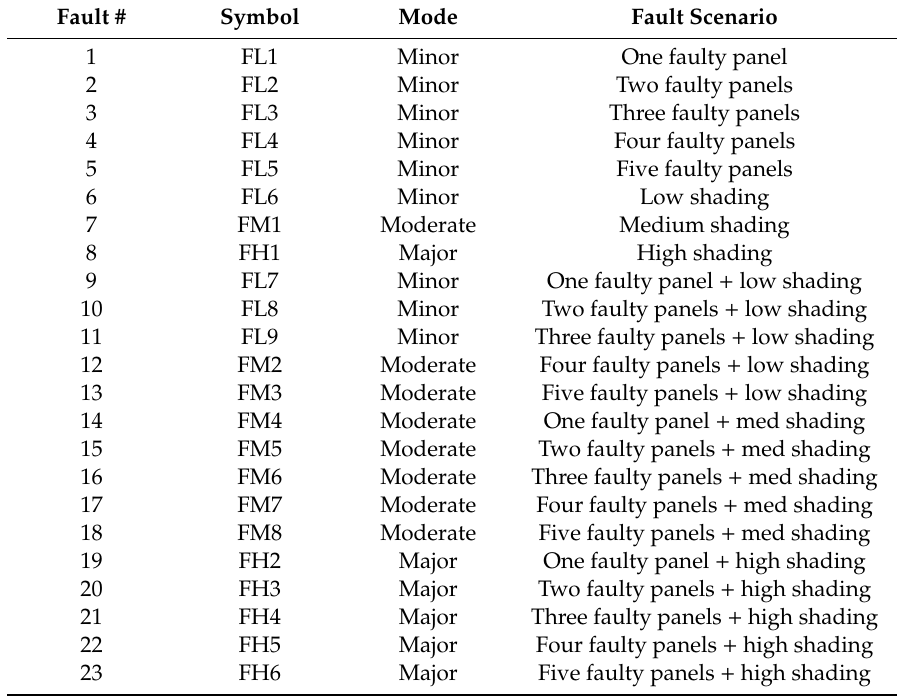
Table 2. PV string fault